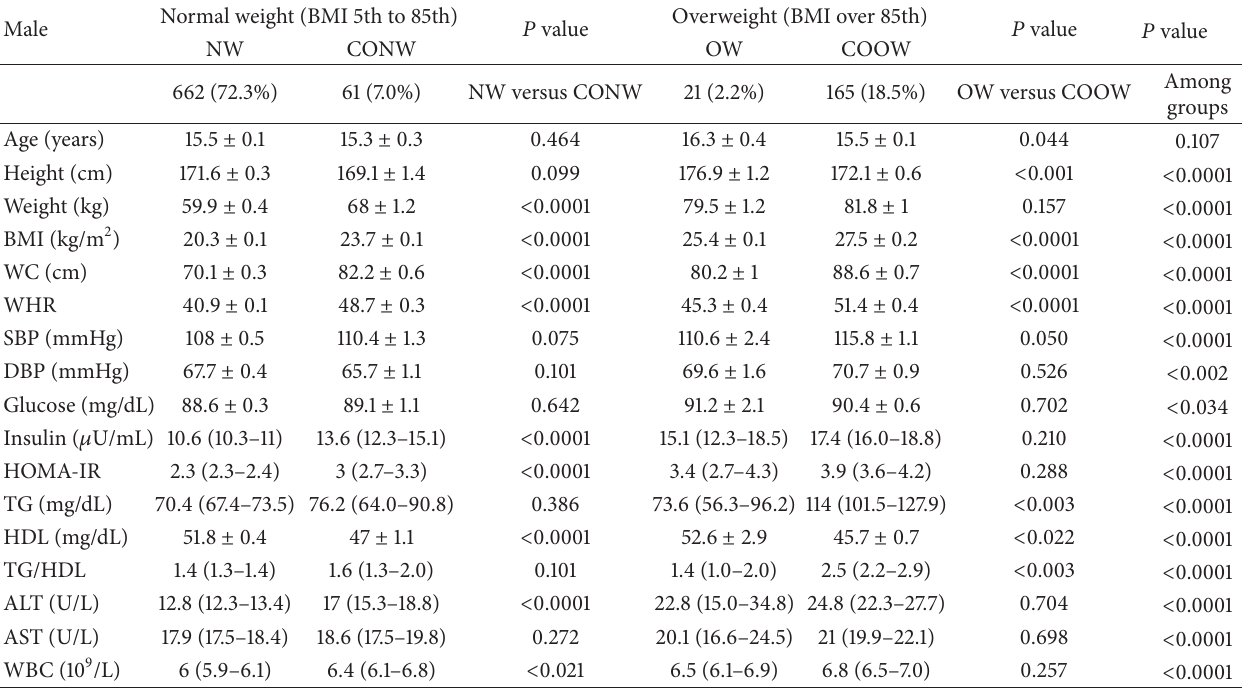
Table 2: Subject characteristics and laboratory data according to four body composition groups in 13–18-year-old male adolescents. Normal weight (BMI 5th to 85th) 𝑃 Male